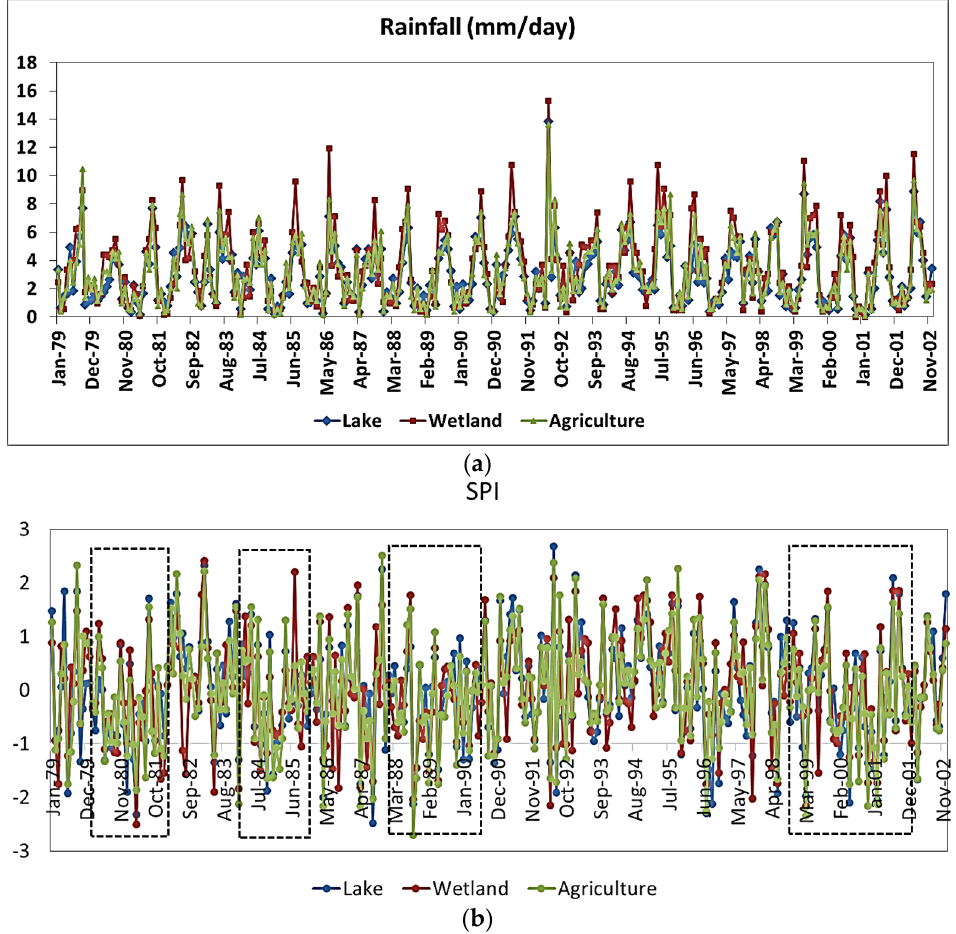
Figure 5. ( a ) Time series for monthly rainfall patterns for South Florida; ( b ) Time series of Standardized Precipitation Index (SPI) for South Florida; dash box areas represent drier periods.